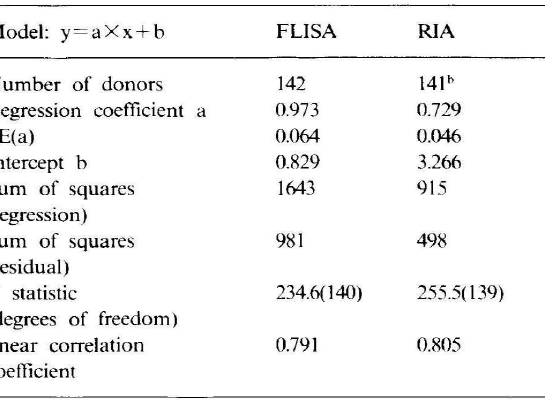
Table 3. Linear regression analysis of neopterin in sera from 142 blood donors, determined by ELISA or RIA Cy", depen dent variable), with HPLC results (~x", independent